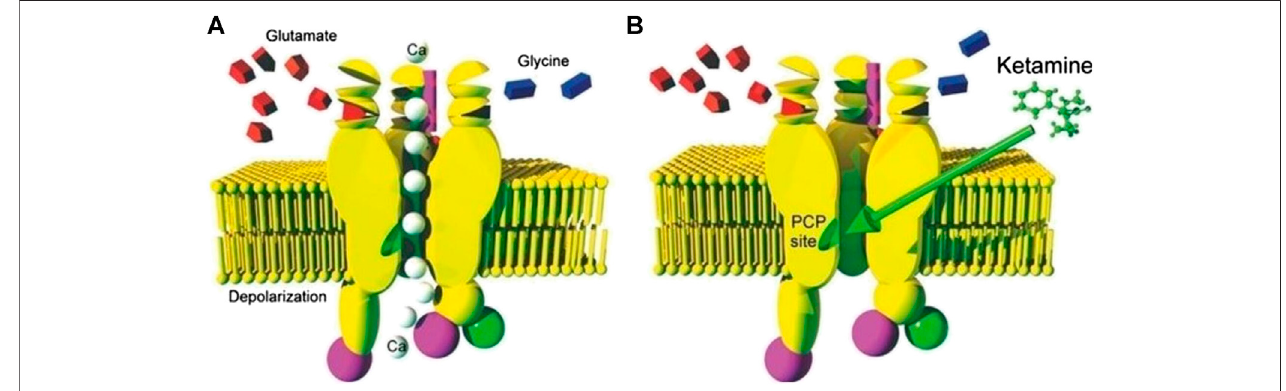
FIGURE2|(A) DepictionofanNMDAReceptorintheopenstateandallowingpassageofcalciumionsduetobindingofglutamateandor/glycin (B) Animageofan NMDA receptor blockaded by binding of ketamine due to binding of the drug at the PCP binding site Mion and Villevieille (2013).